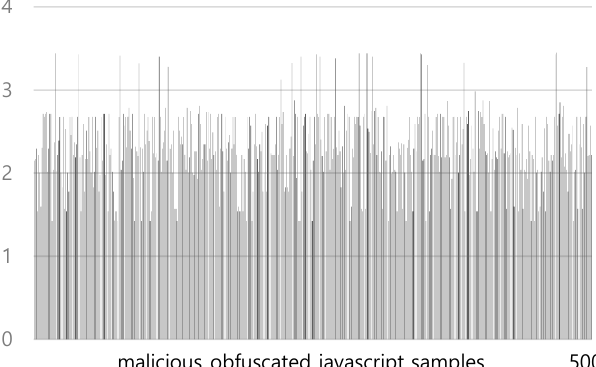
Figure 8. TF-IDF average values over redirection tokens in 500 obfuscated malicious JavaScripts using the conventional TF-IDF.